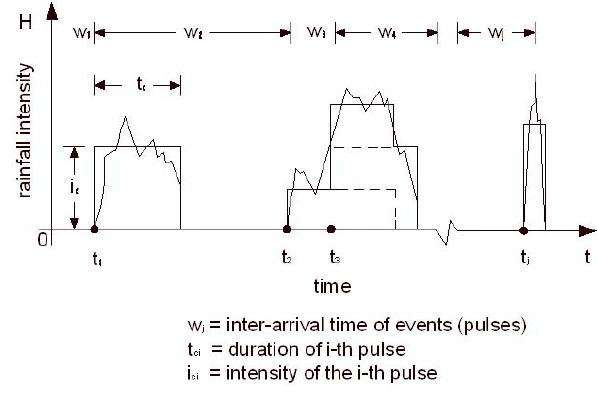
Figure 2 . Schematic representation of PRP model (Rodriguez-Iturbe et alii, 1987) Fig. 2. Schematic representation of PRP model (Rodriguez-Iturbe et alii,